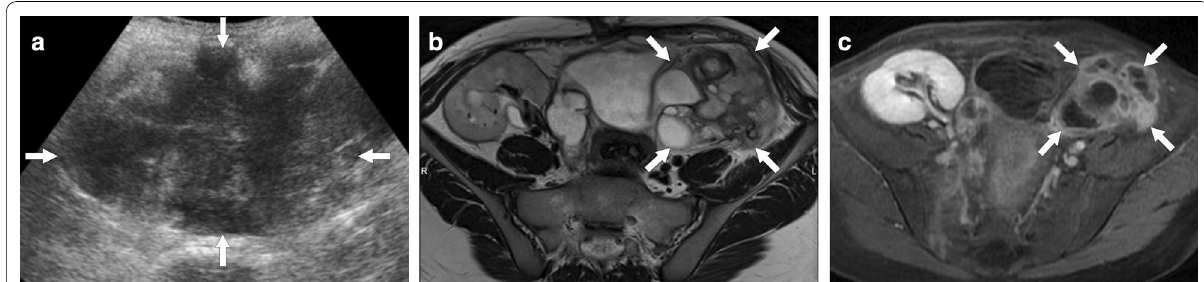
Fig. 24 Pelvic inflammatory disease with tubo-ovarian abscess. A 23-year-old female with high fever, vaginal discharge and pain in her left lower quadrant and deep pelvis. Her medical history included chronic renal failure treated with transplantation. a Transabdominal sonography reveals large, complex-looking, mostly cystic left lower quadrant mass (arrows). b Axial T2W MR image shows a complex-looking mass with internal cystic components (arrows). c Axial postcontrast T1W image demonstrates intense contrast enhancement within the walls of the mass (arrows). Percutaneous aspiration produced pus, and biopsy showed intense inflammatory changes. Cultures grew Escherichia coli , and patient was placed on IV antibiotic treatment after